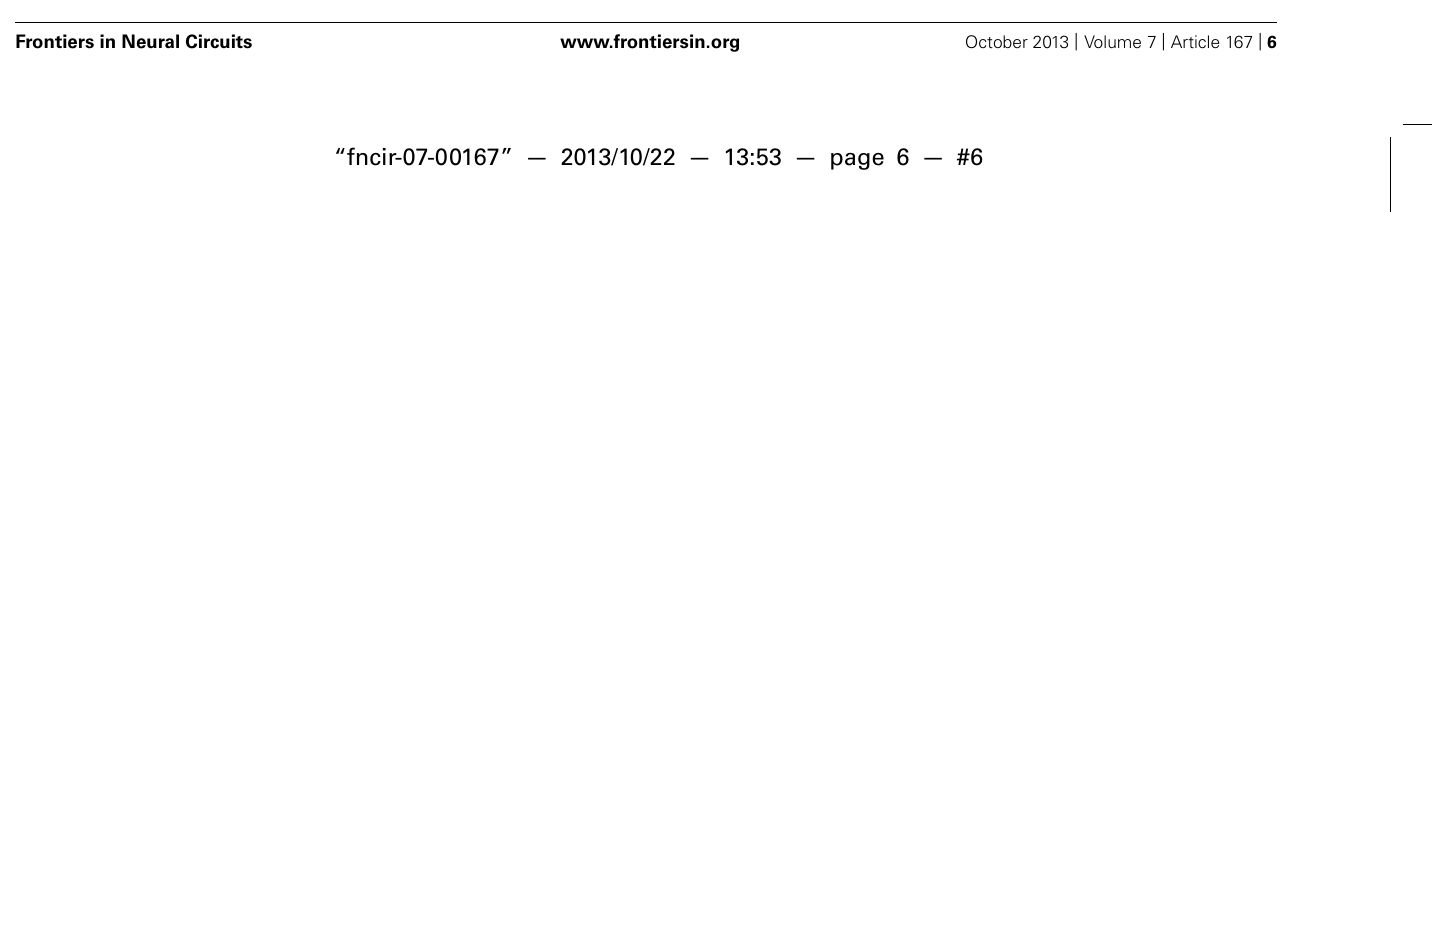
NBQX/Picrotoxin ( n = 10 experiments), and pulsed stimulation on cultures with presence of APV/Picrotoxin ( n = 10 experiments). (E) Cumulative distribution of average FR during stimulus normalized to average FR before stimulus. (F) Average normalized PSTH over all